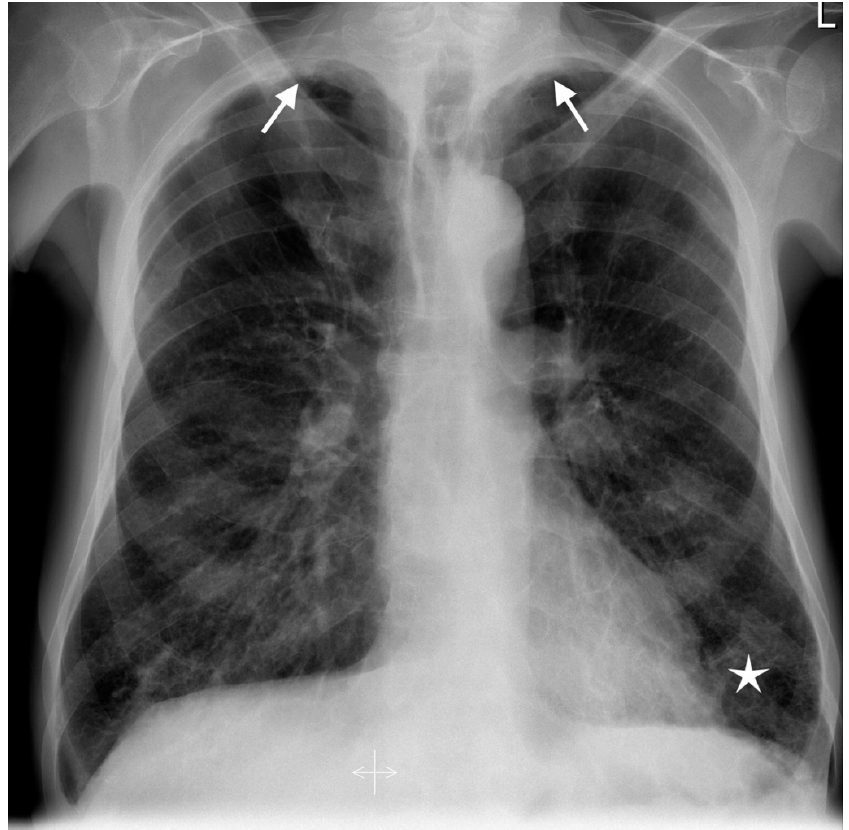
Figure 1. Posteroanterior chest X-ray showing pulmonary emphysema, bilateral apical scaring (arrows), and some reticular and peribronchial lesions in the lower part of the left lung (asterisk). The BD SARS-CoV-2 BD MAX™ real-time RT-PCR test yielded a negative result. La-